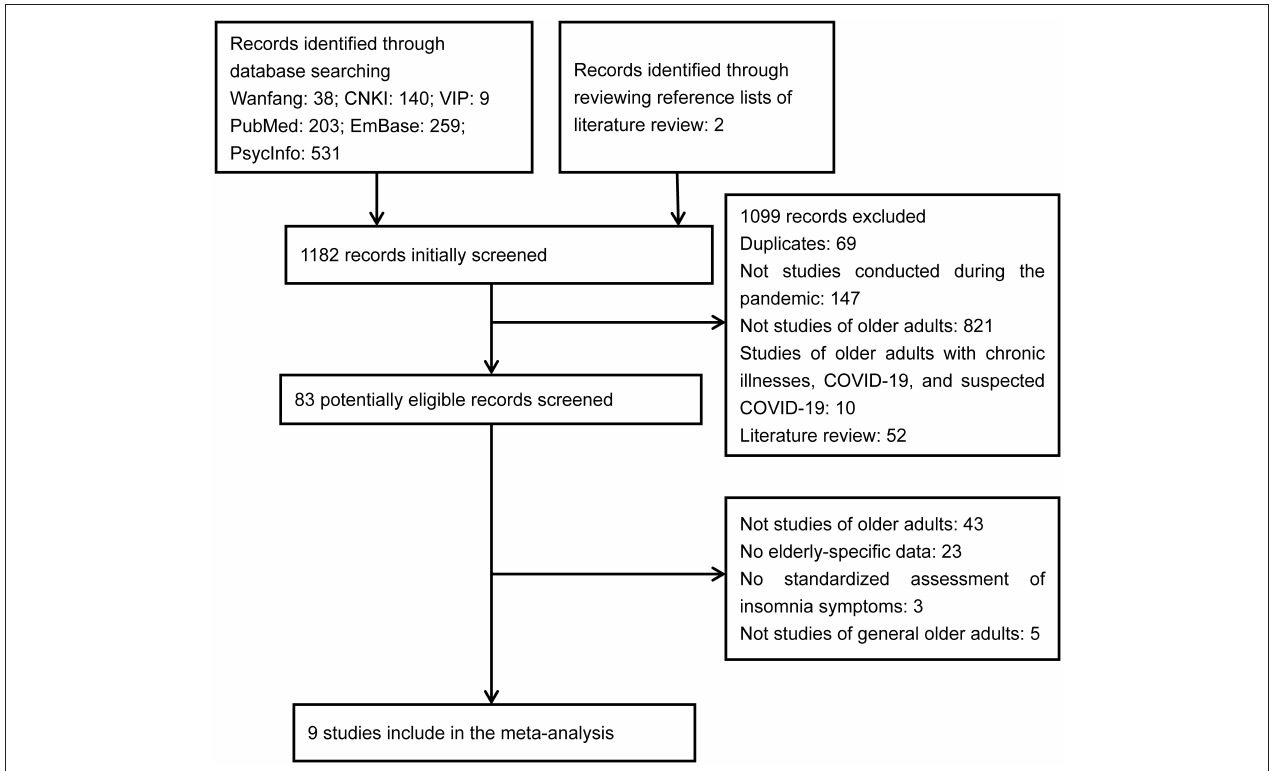
FIGURE 1 | Flowchart of study